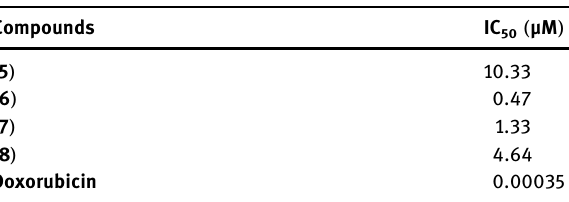
Table 1: Anticancer activity of synthesized compounds